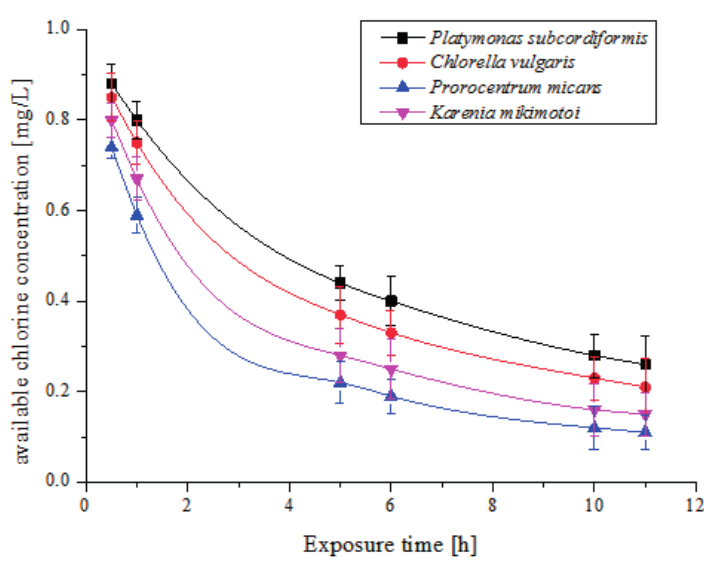
Figure 2. The decay curve of 1 mg/L available chlorine concentration with time for the four microalgae